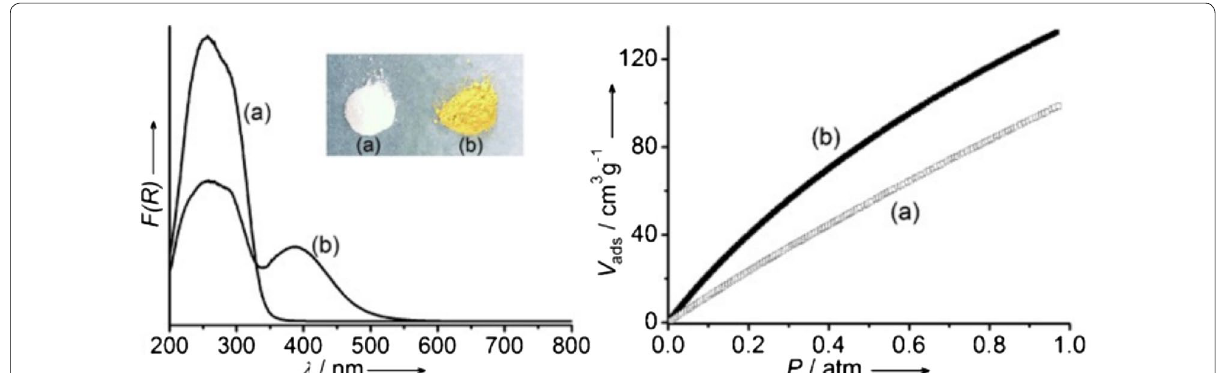
Fig. 3 UV–vis absorption (left) and CO 2 adsorption isotherms (1 atm, 273 K, right) of MIL‑125(Ti) and NH 2 ‑MIL‑125(Ti) . The inset photo shows absorption colors. Copyright permission from Wiley-VCH [93]